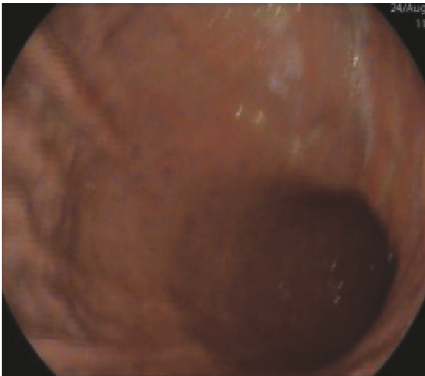
Figure 4: Gastric antrum and body.